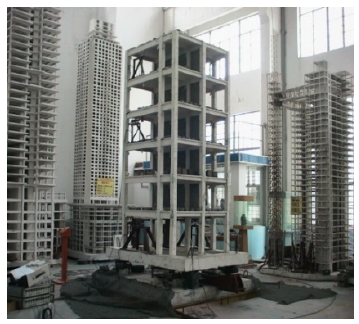
Figure 2. Photo of the experimental structure model.